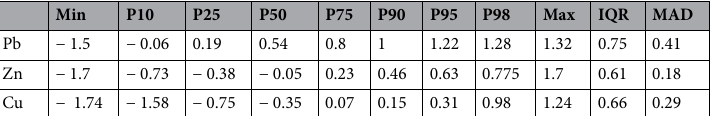
Table 3. Summary table of the main statistical parameters (minimum (Min.), maximum (Max.), percentiles (P) 10, 25, 50, 75, 90, 95, 98, interquartile range (IQR) and median absolute deviation (MAD)) of clr- transformed values of Pb, Zn, Cu.